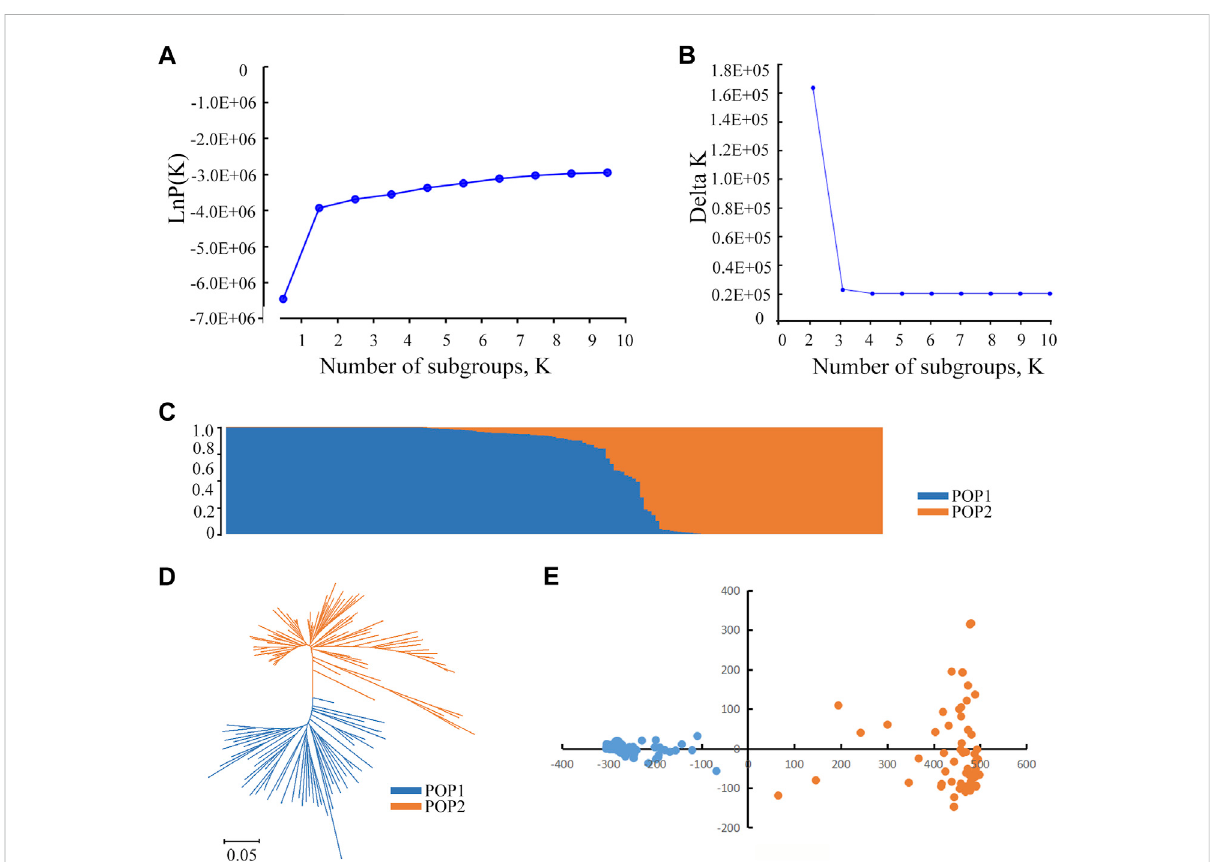
FIGURE 2 Population structure analysis of 173 rice accessions. (A) Changes of the mean LnP(K). A graph of Y axis means of mean LnP(K) and X axis means for the number of subgroups. (B) Changes in the mean delta K. A graph of Y axis means of mean delta K and X axis means for the number of subgroups. (C) The population structure based on a Bayesian model. Each vertical bar represents one accession, and the length of each vertical bar represents the ancestral proportion. (D) Phylogenetic tree of 173 accessions based on whole-genome SNPs. The scale bar at the bottom represents genetic distance. Accessions within different subgroups are displayed by different colors. (E) Principal component analysis showing the population structure in the diversity panel. The red lines indicate Indica accessions. The blue lines indicate Japonica